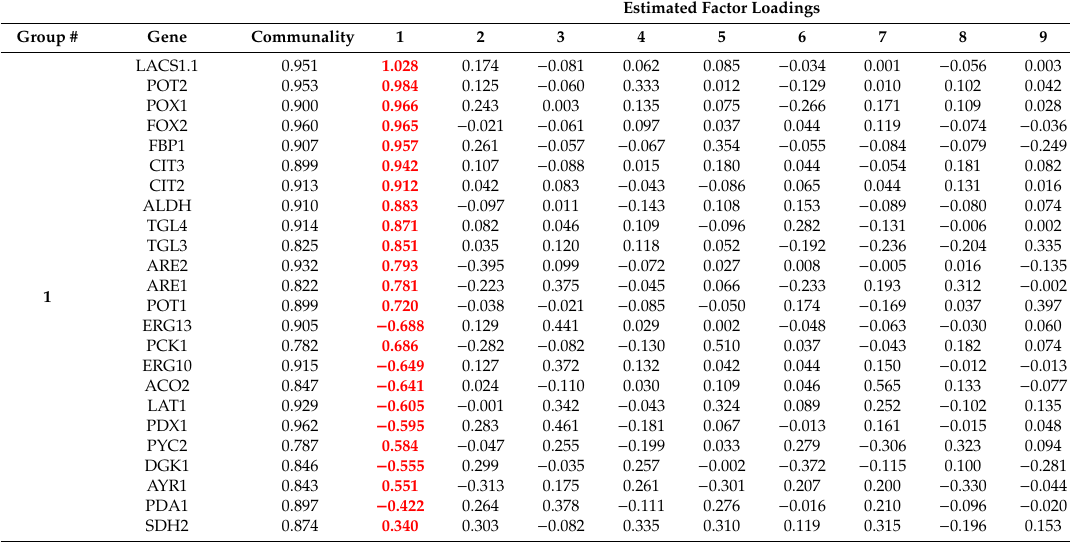
Table 1. Estimated factor loadings and